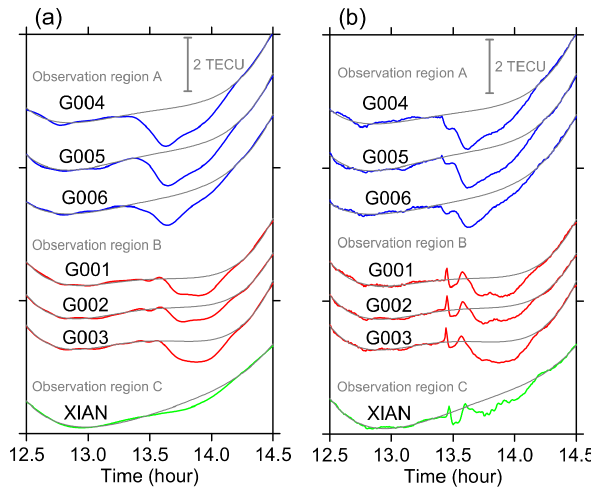
Figure 3. (a) The high frequency part of filtered ionospheric STEC time series for satellite PRN05 of all the seven GPS stations on the day of Tiangong-1 launch (DOY = 272) in three observation re- gions A, B and C by setting a cutoff period of 12min; (b) the local wavelet power spectrum of GPS station G005 for satellites PRN05; (c) the local wavelet power spectrum of GPS station G002 for satel- lites PRN05; (d) the local wavelet power spectrum of GPS station XIAN for satellites PRN05.